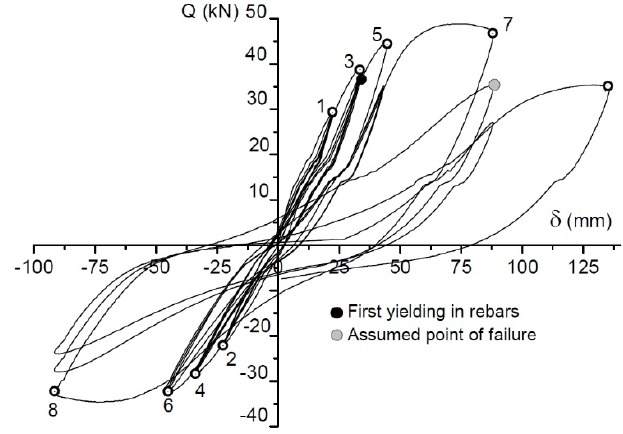
Figure 13 . Load ‐ displacement curves of beam ‐ column connection.